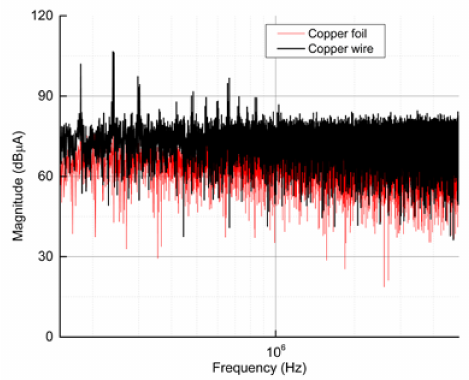
Figure 14. Comparison of the high frequency current spectrum at the grid